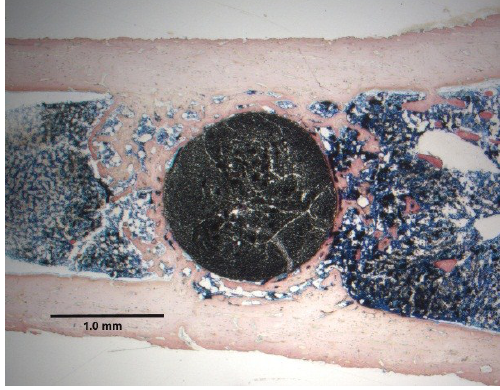
Figure 5. Sanderson’s stain epoxy/carbon fiber PMC horizontal section at 2× magnification in the marrow space shows mature organized pores in osseointegrating bone with the implant.